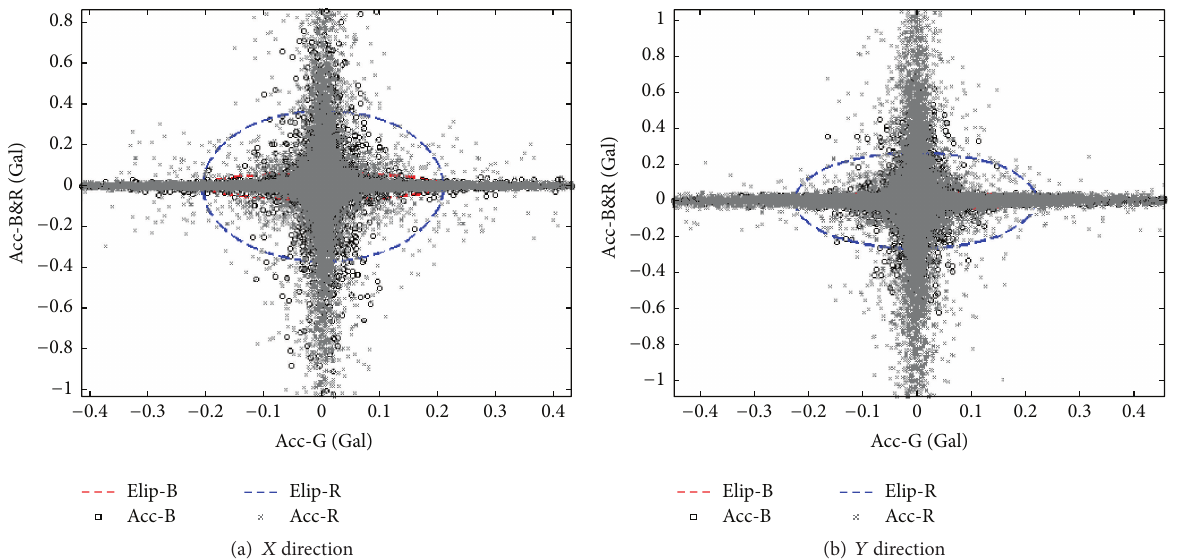
Figure 8: Ellipse error for the base and roof responses during the earthquake shaking.